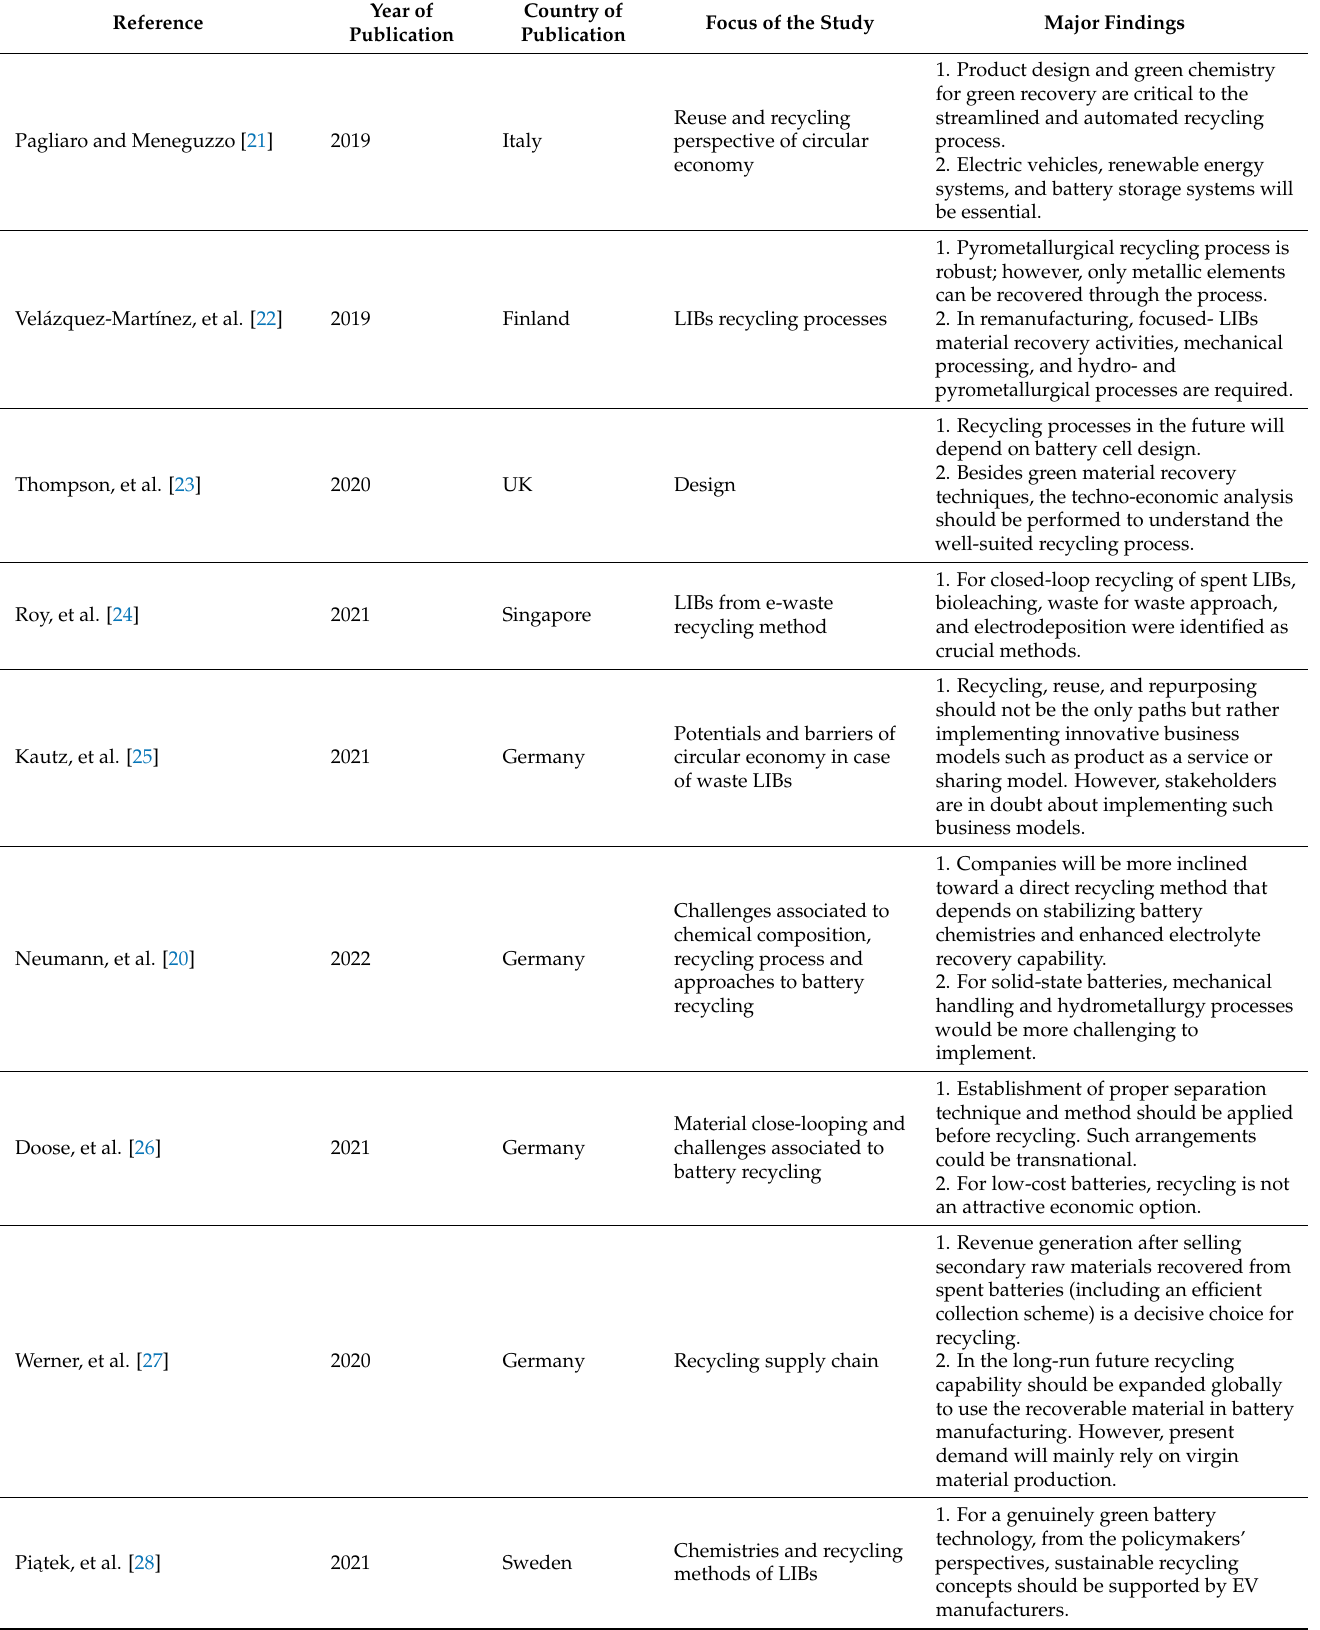
Table 1. Summary of the previously published review articles on recycling and circular